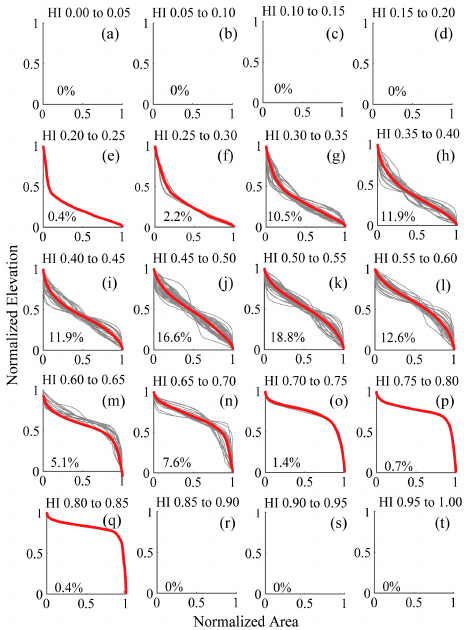
Figure 6. The HI values of basins. ( a – t ) represent the statistics of HI, 0.05 was used as a statistical unit. The gray lines are the HI curves of the basins and the red lines indicate the mean values.